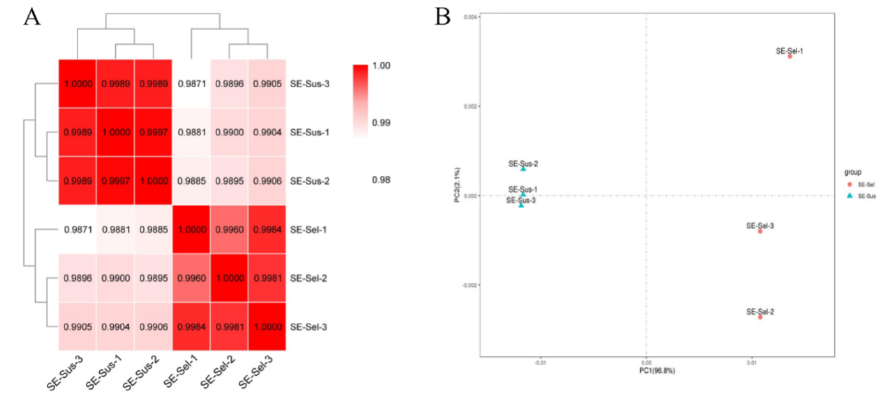
Figure 3. Heat map and principal component analysis (PCA) of gene expression levels in the six samples. ( A ) Heat map; ( B ) Principal component analysis (PCA). In Figure 4A, the darker the color is, the greater the correlation is.